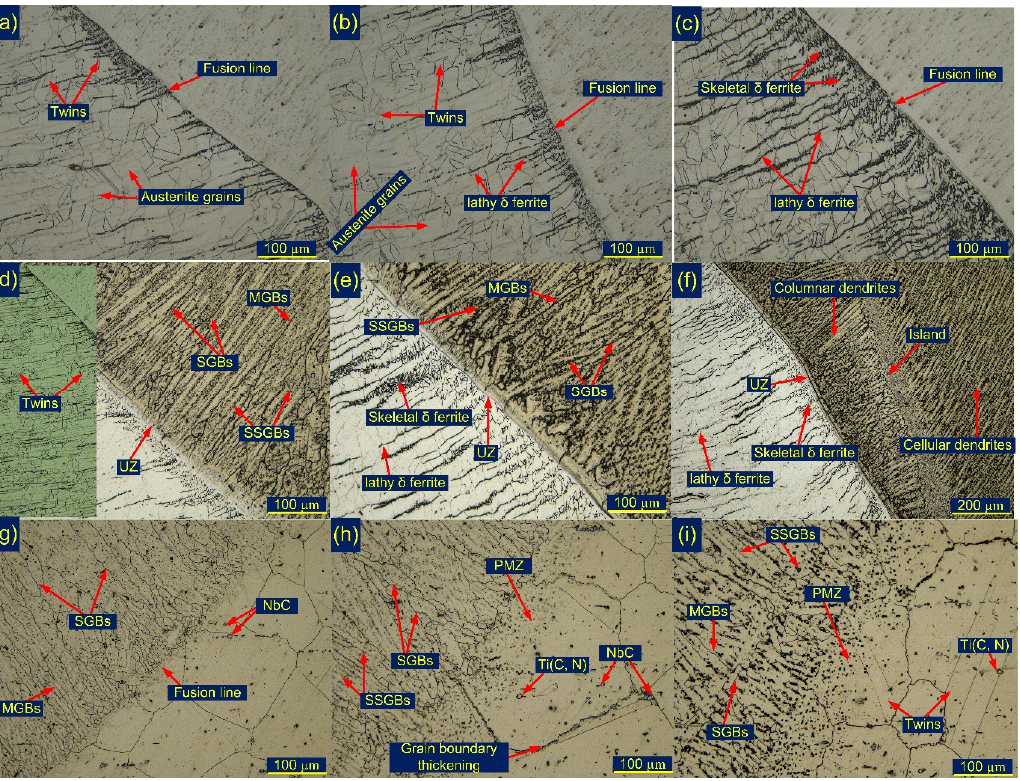
Figure 4. Micrograph of the interface region of the 304L SS side BM after etching with aqua regia ( a – c ); after electrolytic etching ( d – f ); interface on the side of IN718 BM ( g – i ). An SEM image corresponding to the interface of the weld metal and the BMs is de- picted in Figure 5a,b. The interface, along 304L SS, consists of a considerable unmixed zone (UZ), columnar dendrites in the weld metal, and lathy δ ferrite in the 304L SS HAZ (Figure 5a). A sharp compositional gradient for elements Fe, Ni, Cr, and Mn exists along